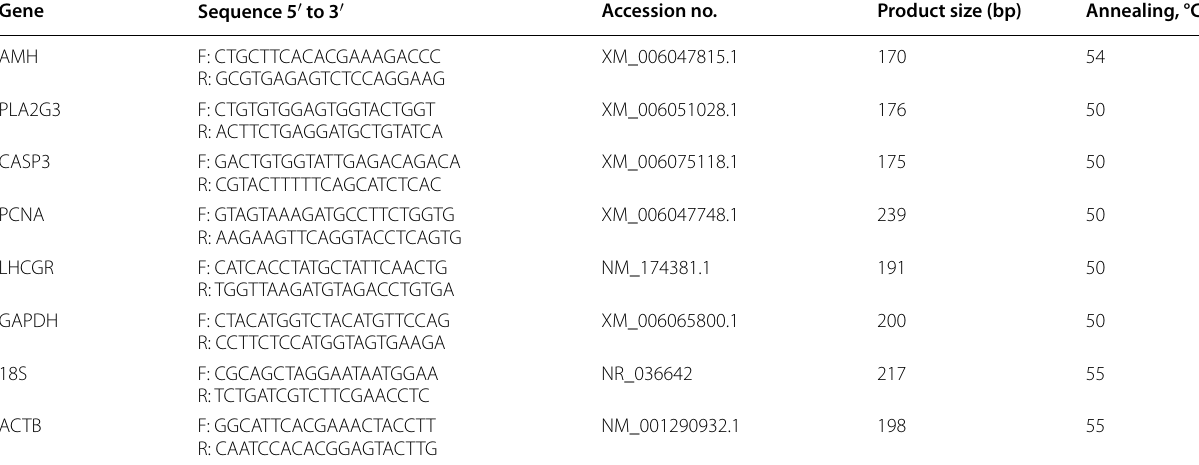
Table 1 List of primers used Gene